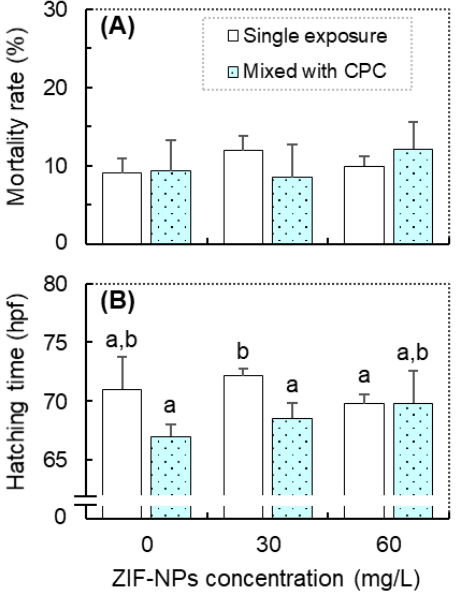
Figure 1. The mortality rate ( A ) and average hatching time ( B ) of zebrafish ( Danio rerio ) in the combined exposure groups of cetylpyridinium chloride (CPC, 0 and 20 µ g/L) and ZIF-8 nanoparticle (ZIF-NPs; 0, 30, and 60 mg/L). Data are means ± SE ( n = 3), and values that do not share a common letter are significantly different at p <